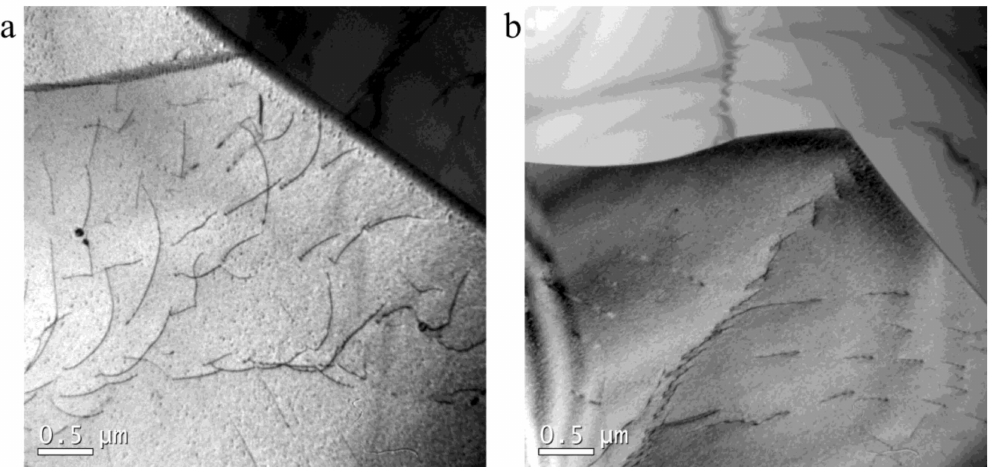
Figure 11. Dislocation morphology in subgrain in 18Mn18Cr0.6N steel compressed at a cooling rate of 0.0125 Ks − 1 to different strains: ( a ) 0.4; ( b )